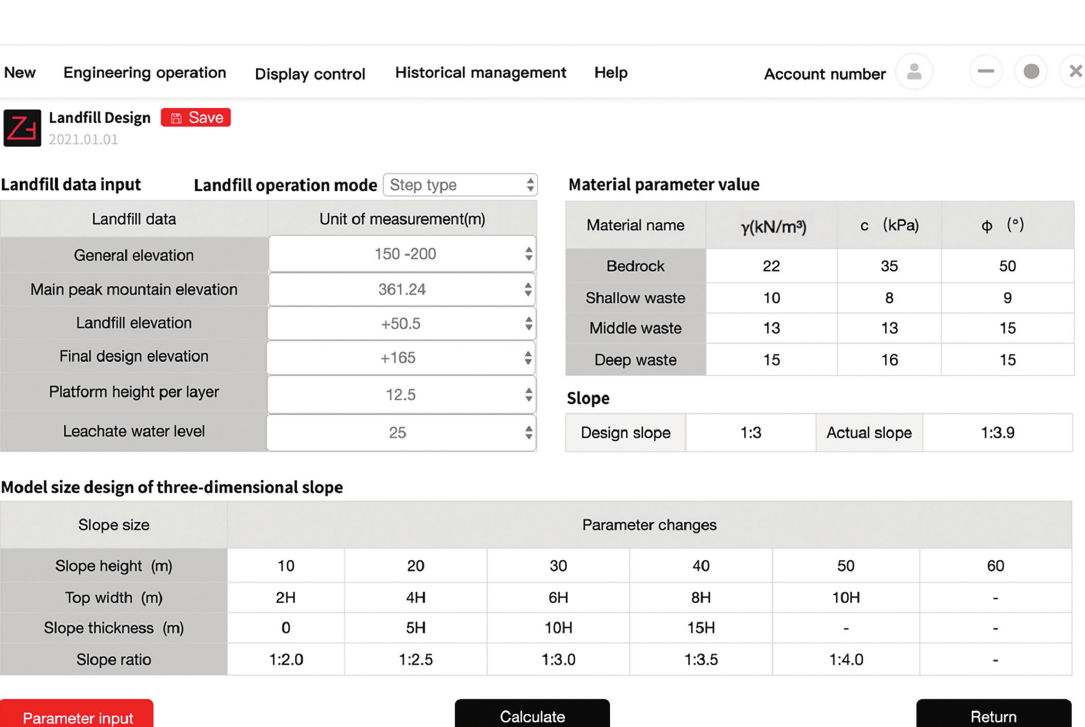
Figure 2: Landfill parameter input.